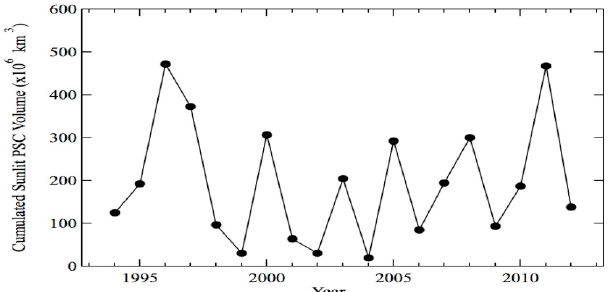
Fig. 10. Maximum PV gradient at 475K indicative of vortex Fig. 11. Cumulated sunlit VPSC between 400–675K since 1994. strength. The 2011 vortex was stronger than all others after mid- Figure 11. Cumulated sunlit VPSC between 400-675 K since 1994. The PSC volume in 2011 Figure 10. Maximum PV gradient at 475 K indicative of vortex strength. The 2011 vortex was The PSC volume in 2011 was of same order of magnitude to that of February. stronger than all others after mid-February. was of same order of magnitude to that of 1996. Table 3. ERA-Interim–ECMWF operational analyses mean differ- ence of minimum temperature poleward of 60 ◦ N in the winter be- tween 1994 and 2012.